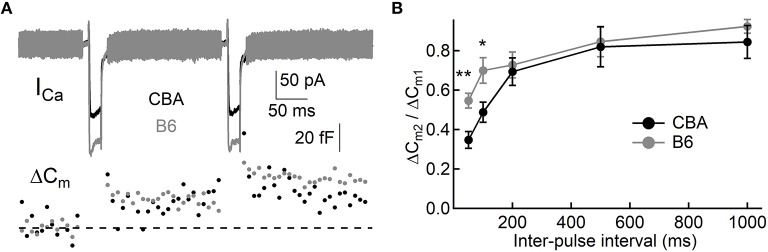
Synaptic vesicle replenishment in IHCs. (A) Representative current responses of two IHCs to double pulse stimulation, one from each mouse strain. Both pulses (20 ms) induced notable ICa and ΔCm, and the ratio of ΔCm2/ΔCm1 can be calculated and used to quantify synaptic vesicle replenishment. (B) Synaptic vesicle replenishment was significantly faster in IHCs from B6 mice. * means p < 0.05 and ** means p < 0.01.